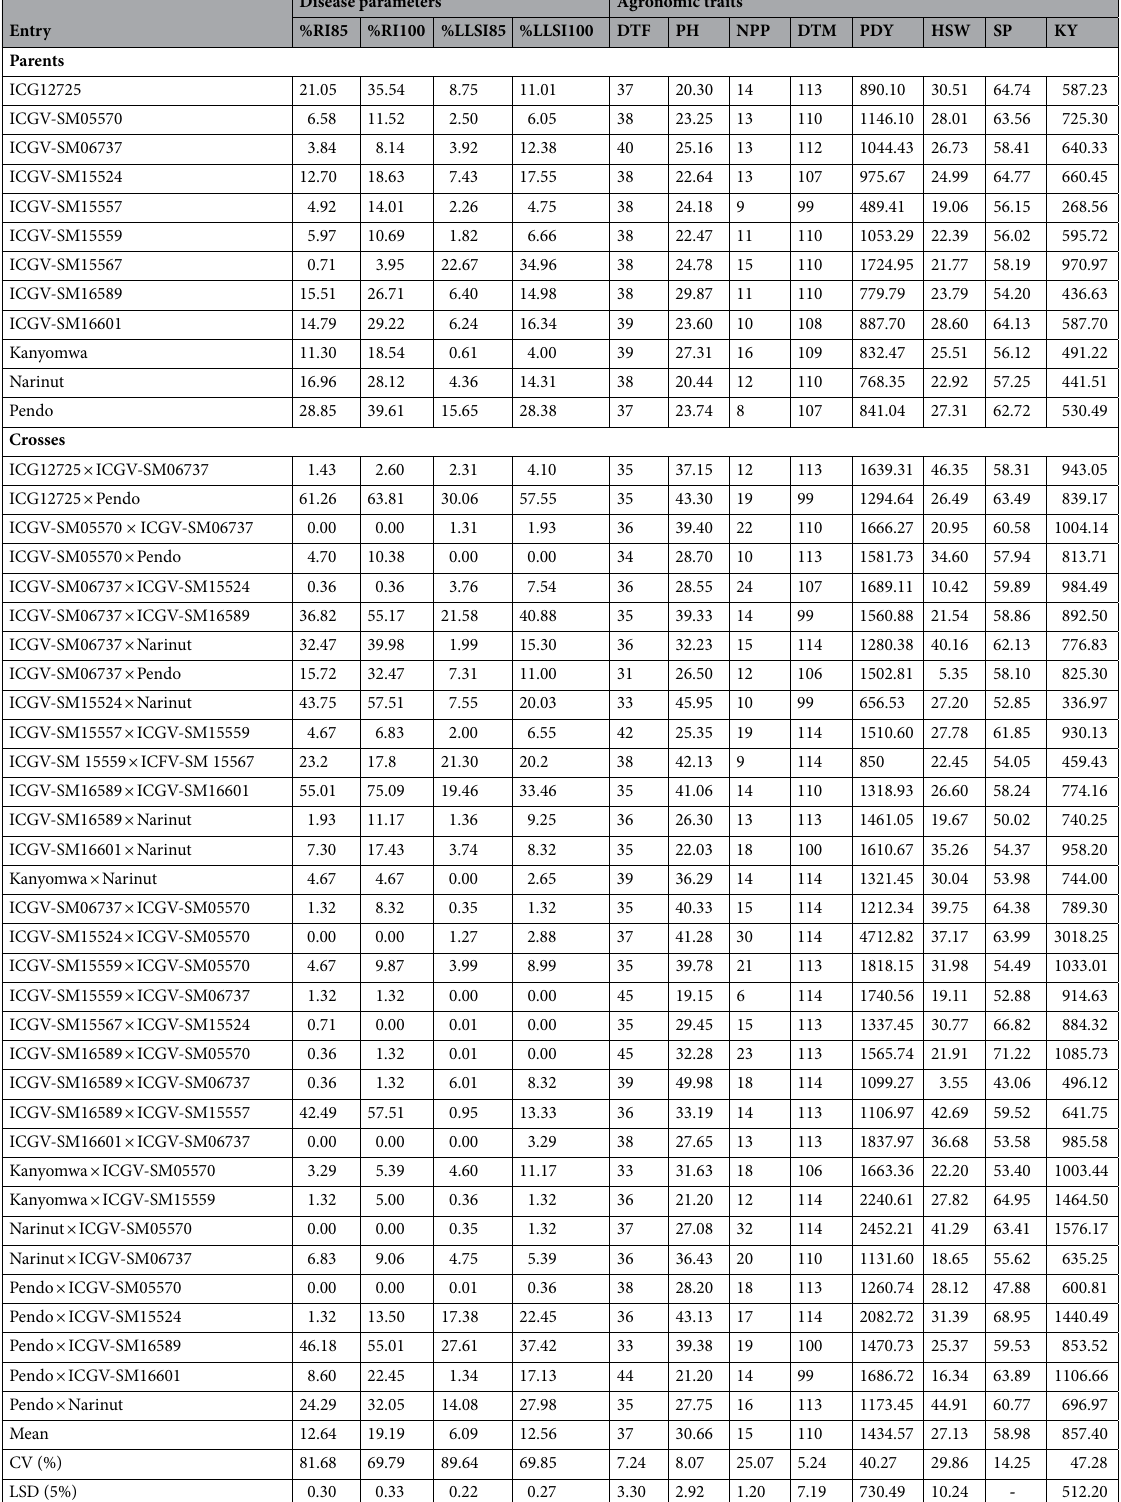
Table 5. Mean values of four disease parameters and eight agronomic traits of 12 parental genotypes of groundnut and their 33 F 2 families evaluated in two seasons in Tanzania. %RI85 percentage rust infection